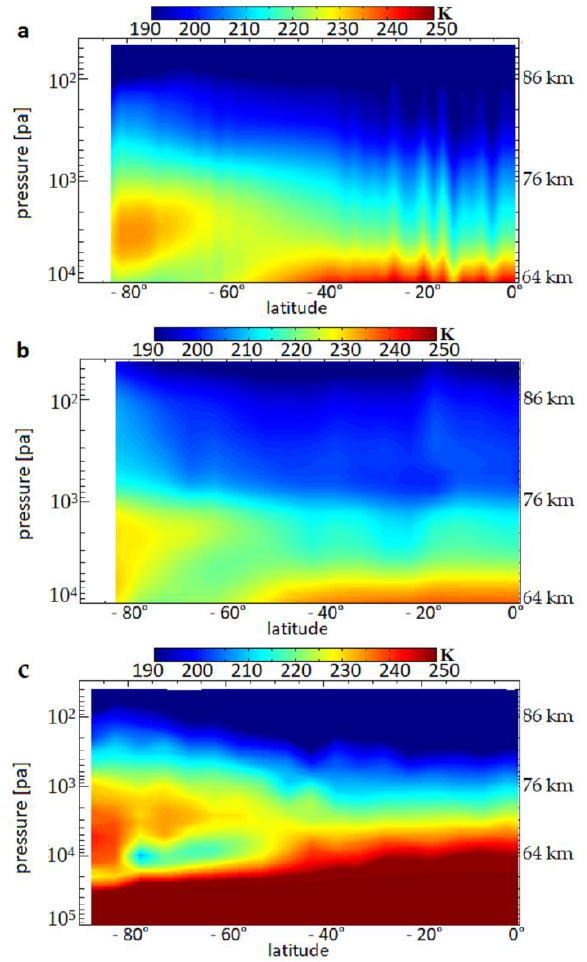
Figure 2. Altitude-latitude distribution of the zonal and temporal average temperature field (K). ( a ) VIRTIS-M (Visible and Infrared Thermal Imaging Spectrometer Spectral Mapper); ( b ) VIRTIS-H (VIRTIS High-Spectral Resolution); ( c ) Venus Express Radio Science Experiment (VeRa). The average has been obtained over 360° of longitude and the entire night.